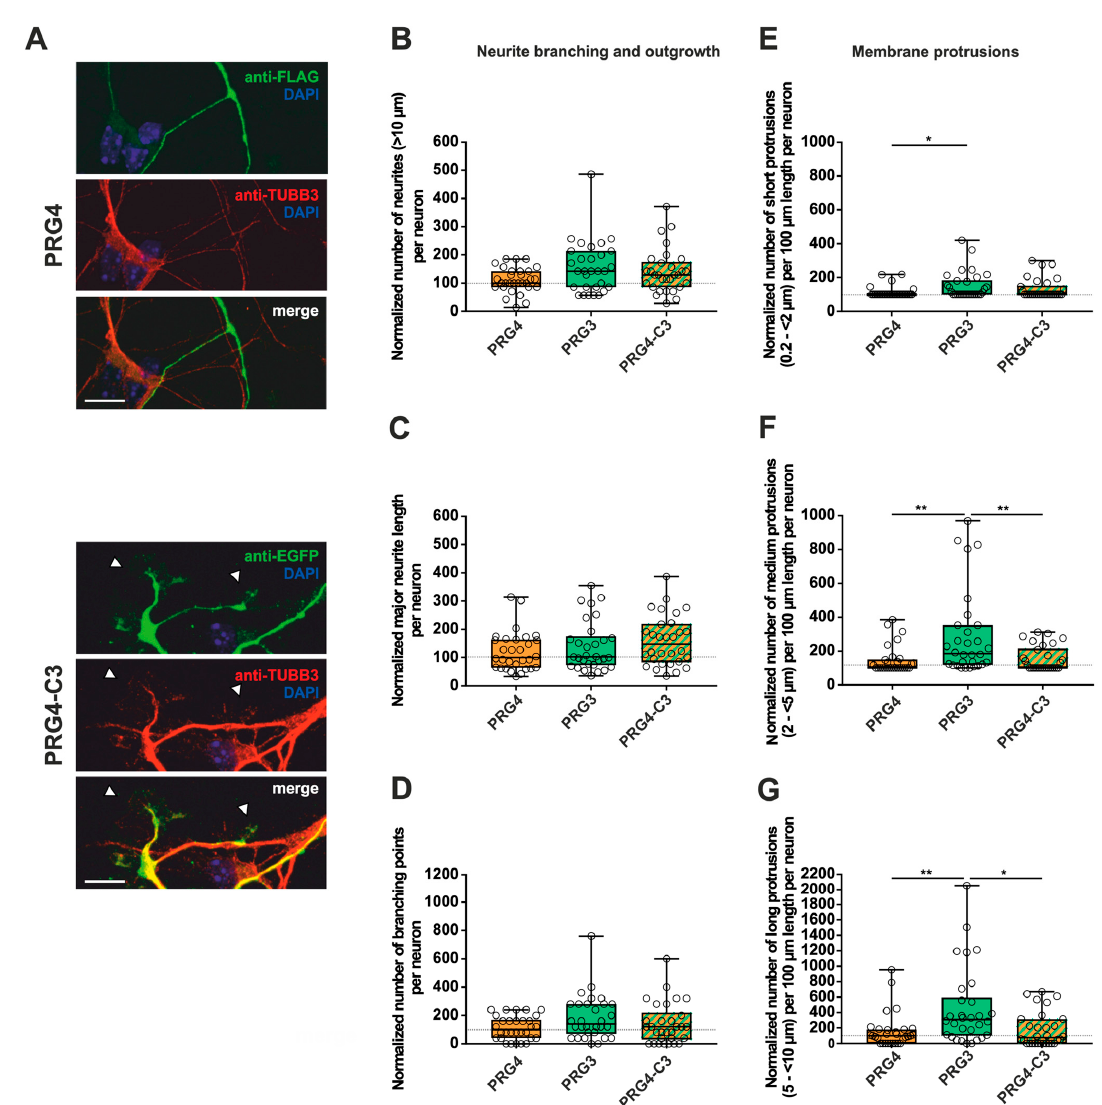
Figure 6. The PRG3 C-terminal domain is crucial for neurite growth and membrane protrusions, but is not capable of restoring the full function of PRG3 when fused to PRG4. Subcellular distribution of PRG4- and PRG4-C3-encoding fusion proteins in immature primary hippocampal neurons in culture. Hippocampal neurons in culture were transfected at DIV1 with ( A ) either PRG4- (upper panel) or PRG4-C3-encoding plasmids (lower panel) and analyzed at DIV2. Confocal stacks of representative neurons with immunocytochemistry of the respective fusion proteins stained for FLAG (green, PRG4) or GFP (green, PRG4-C3) to visualize the morphology of the cell or tubulin are shown. Arrowheads denote membrane localization. The scale bar represents 10 µ m. Boxplot showing the quantification of ( B ) the total number of neurites; ( C ) the quantification of major neurite length and ( D ) the number of branching points in PRG4-, PRG3- and PRG4-C3-overexpressing neurons. Quantification of membrane protrusions in subgroups based on length in the ( E ) group of short protrusions (0.2–<2 µ m) (* p ≤ 0.01) and in subgroups of ( F ) medium protrusions (2–<5 µ m) and ( G ) long protrusions (5–<10 µ m) (* p ≤ 0.01, ** p ≤ 0.001). (PRG4 n = 30, PRG3 n = 30, PRG4-C3 n = 30 neurons). All data are presented as median and IQR. Boxes range from 1st to 3rd quartile. Horizontal lines represent medians. Whiskers represent minimum and maximum. Dots represent the values of individual neurons. Statistical analysis was performed using the Kruskal–Wallis test. A level of confidence of p ≤ 0.05 was adopted (* p ≤ 0.05, ** p ≤ 0.01,). PRG4 was always set to 100 and ratios of changes of the different morphology analyses are shown ( B – G